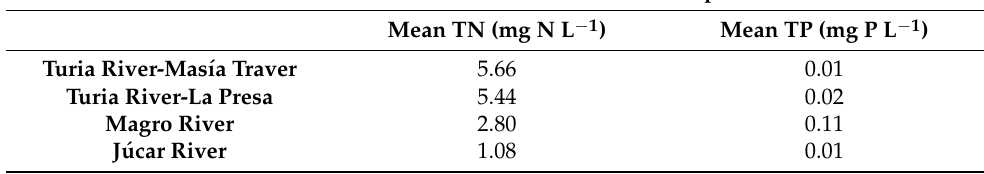
Table 2. Average concentrations of TN and TP reached in the Turia, Magro and Jucar rivers during the rice cultivation period (May 2019–October 2019).